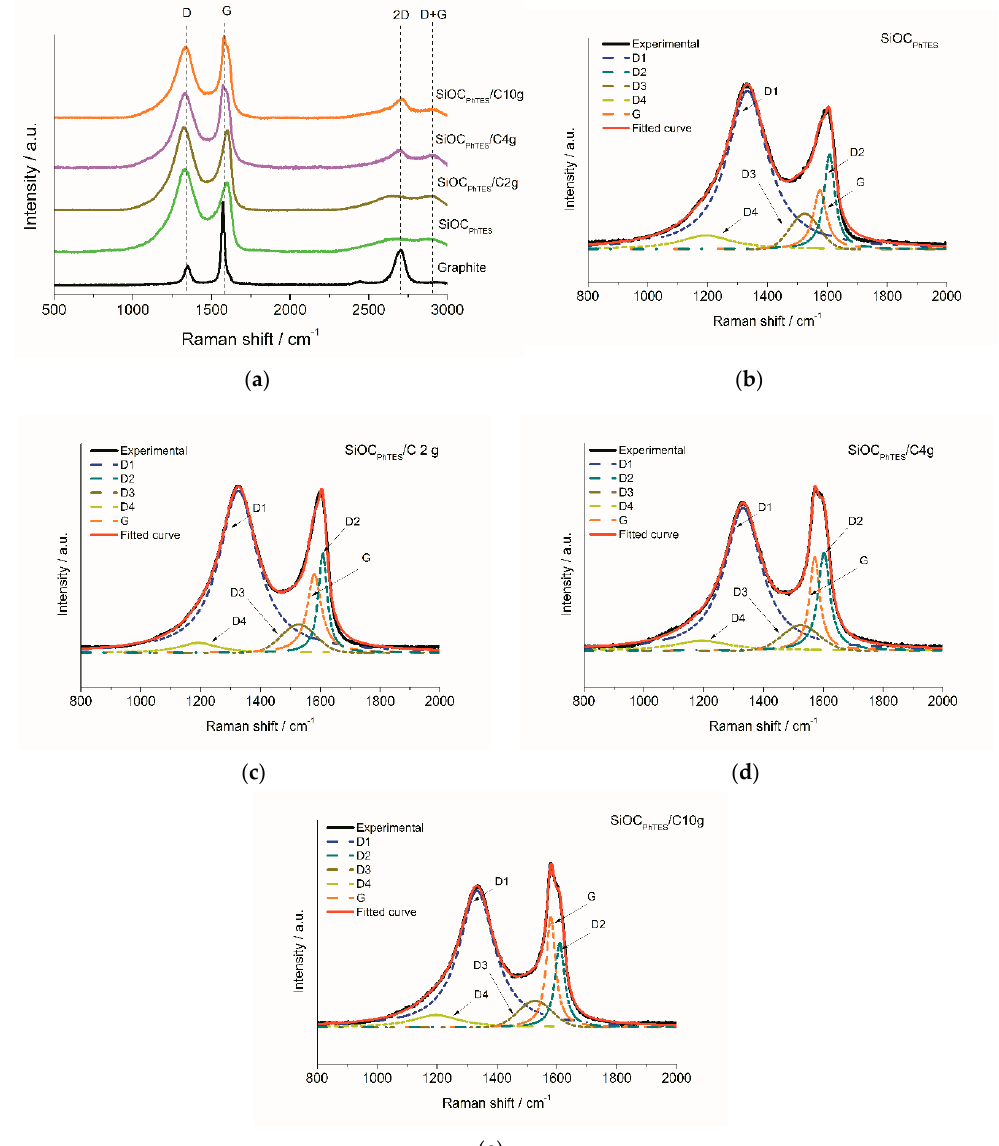
Figure 4. ( a ) Comparison of Raman spectra recorded for investigated samples. Fitting of the Raman spectra of: ( b ) SiOC PhTES , ( c ) SiOC PhTES /C2g, ( d ) SiOC PhTES /C4g and ( e ) SiOC PhTES /C10g samples.